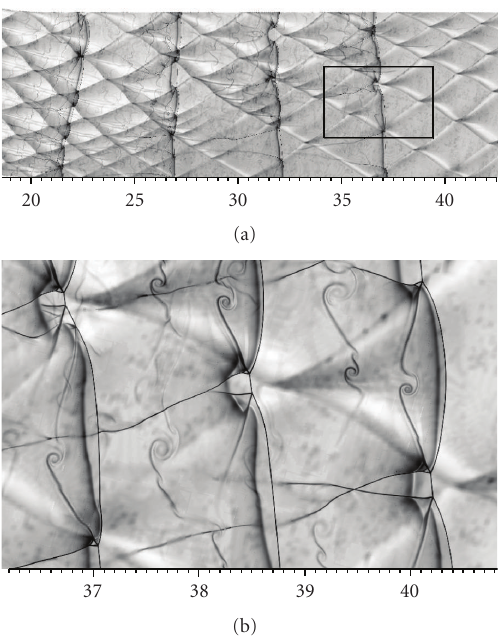
Figure 25: (a) Cellular structure after the bend (shown rotated) for ϕ = 15 ◦ , (b) triple point re-initiation with change from TMR to DMR. The physical time steps 200 μ s, 210 μ s, and 220 μ s are